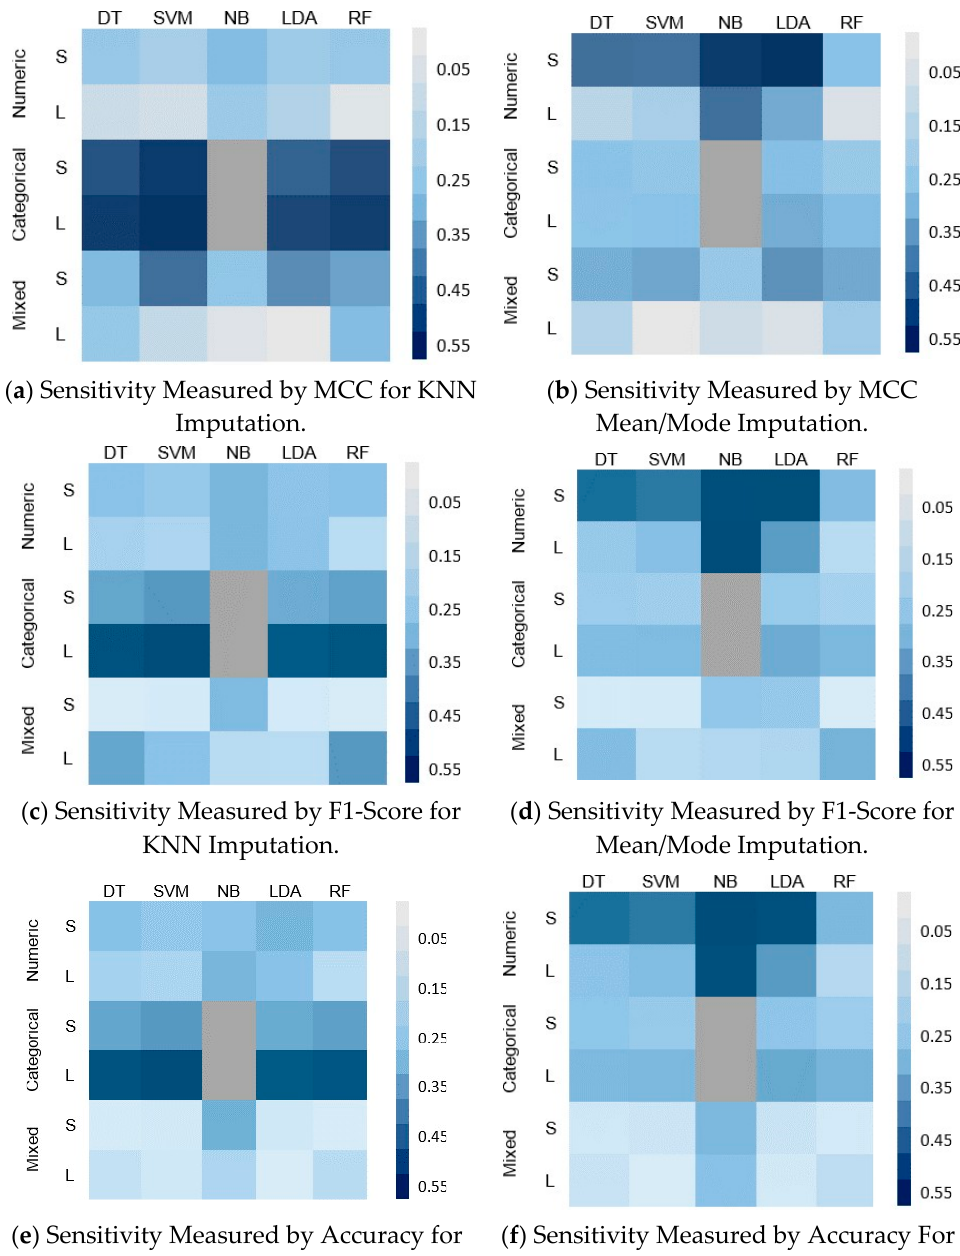
Figure 6. Classifier sensitivity of the five classifiers on different sizes and types of dataset with MCAR MVs.